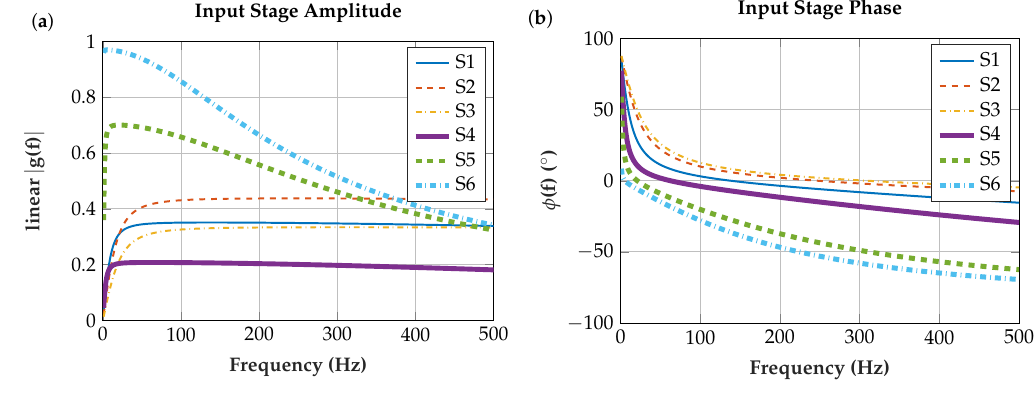
Figure 14. Transfer functions from input stage to input of the INA for the six different sensor assemblies: ( a ) amplitude response; and ( b ) phase